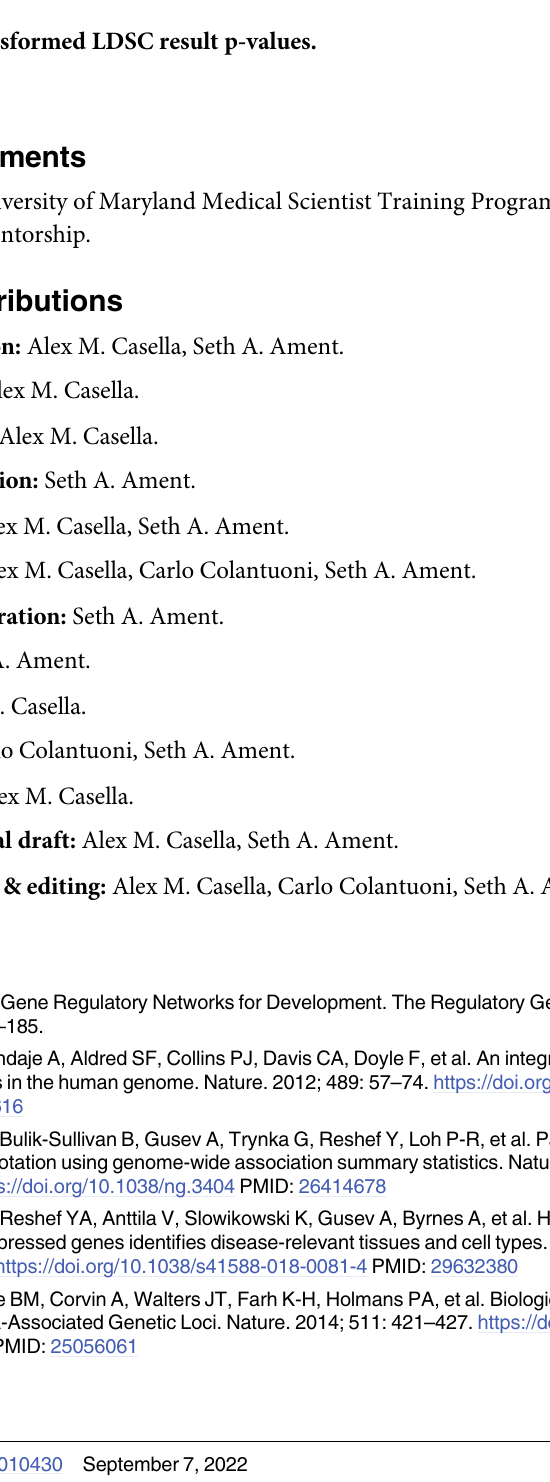
S2 Table. Meta-analyzed and single enhancer annotation TF schizophrenia RWAS results in the adult and fetal brain. S3 Table. Genome-wide significant enhancer hits within SCZ risk loci across 127 human tissues. Sample names are as described in the ROADMAP epigenomics project integrative